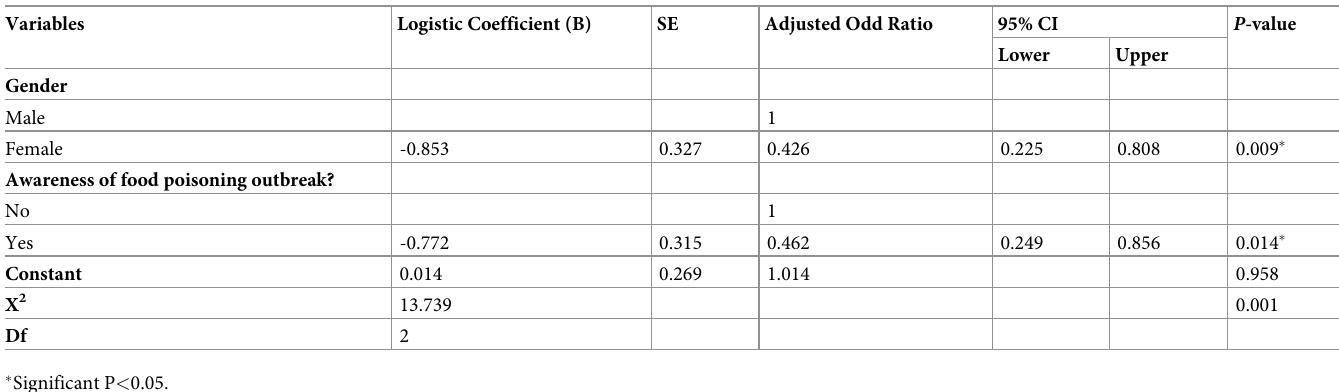
Table 14. Predictors influencing the attitude of respondents towards food poisoning.